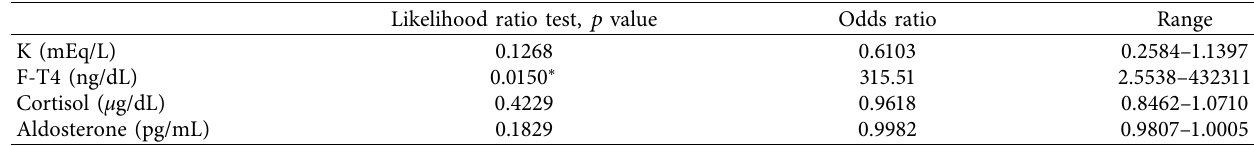
Table 2: Multiple logistic regression analysis for ROSC using K, F-T4, cortisol, and aldosterone levels.